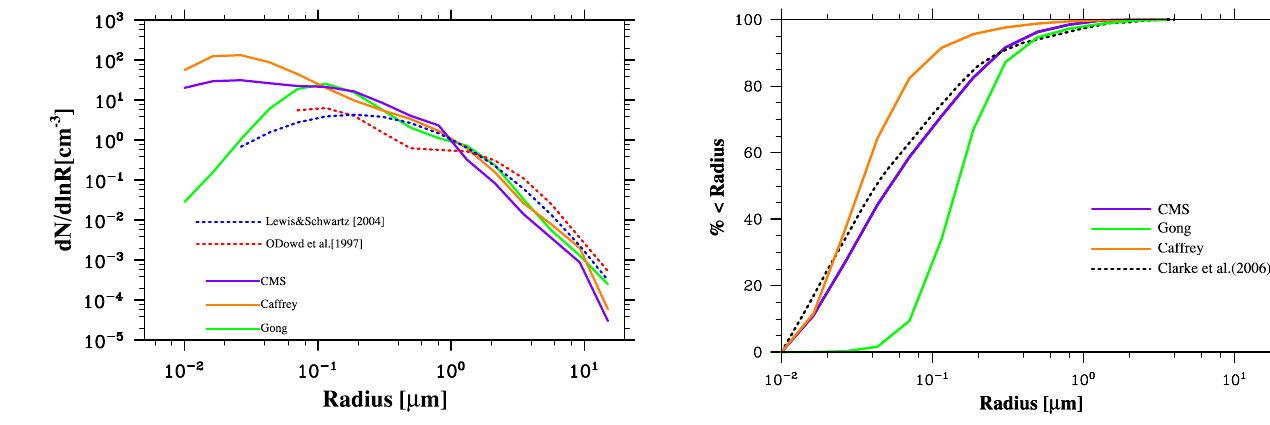
Fig. 17 is normalized. All source functions for mass